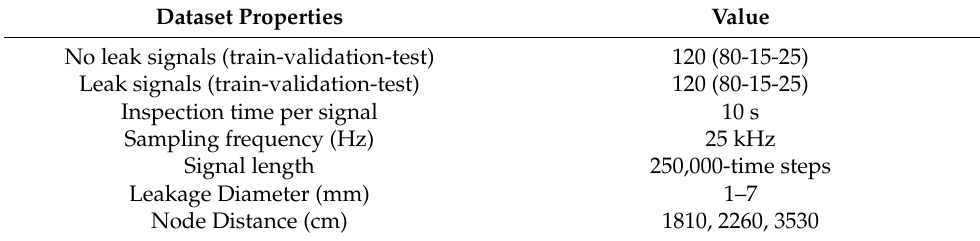
Table 2. Dataset